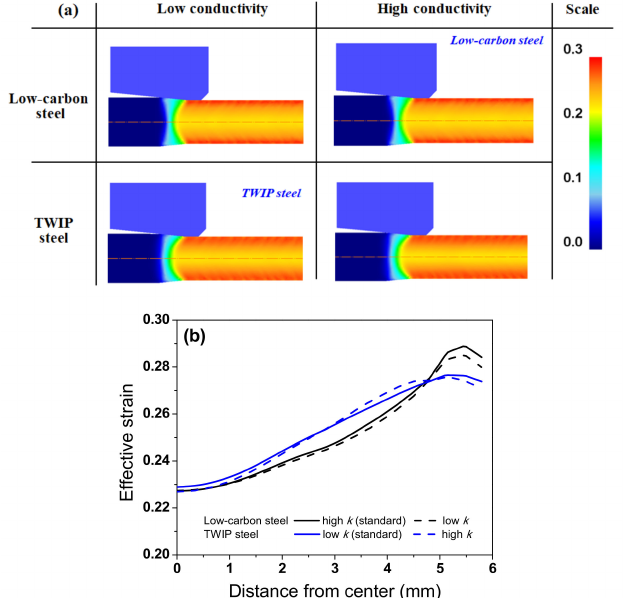
Figure 10. Comparison of effective strain ( a ) contours and ( b ) profiles along the radial direction of low-carbon and TWIP steels with different thermal